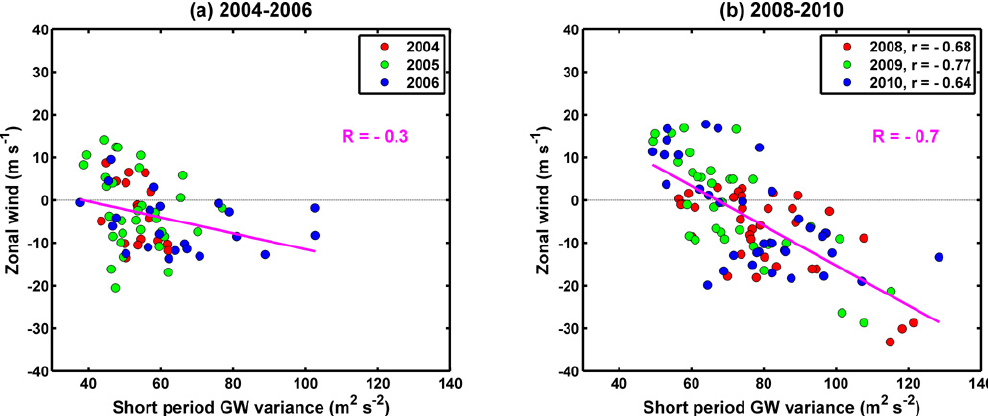
0 2 + 0 2 v ) /2) for (a) 2004–2006, and (b) 2008–2010.